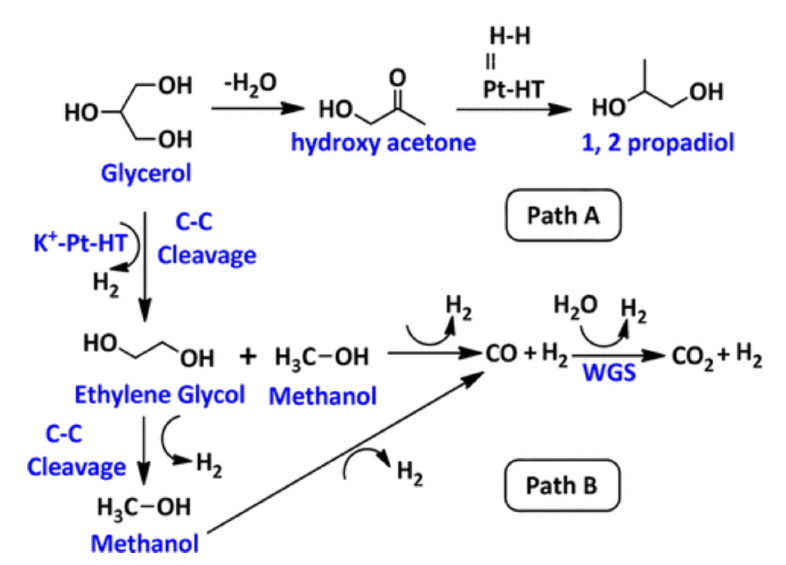
Figure 16. Reaction pathway of H 2 formation in glycerol reforming promoted by K [221]. Copyright 2017, American Chemical